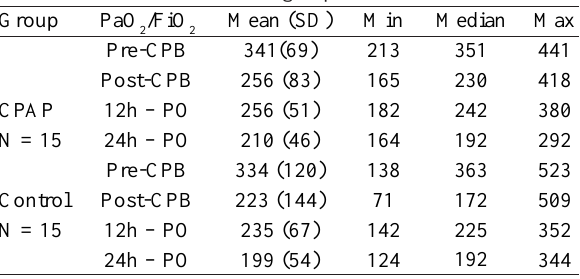
/FiO (mmHg) at different observation moments Table 2. PaO 2 2 in CPAP and control groups.